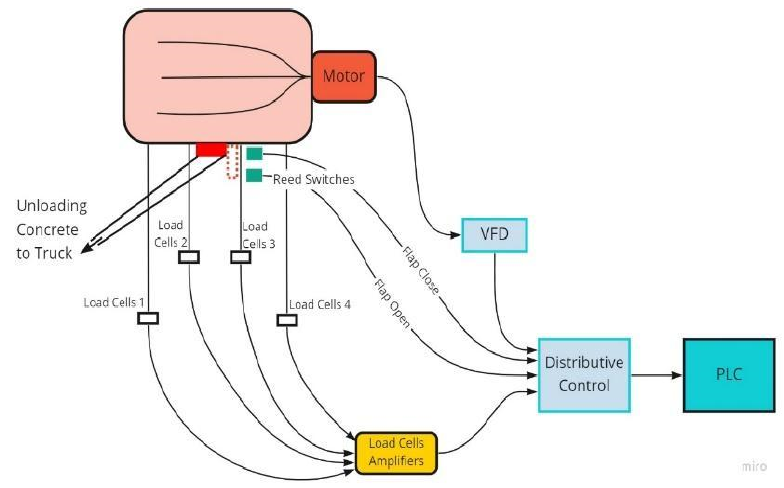
Figure 12. Concrete Mixing and Truck Loading